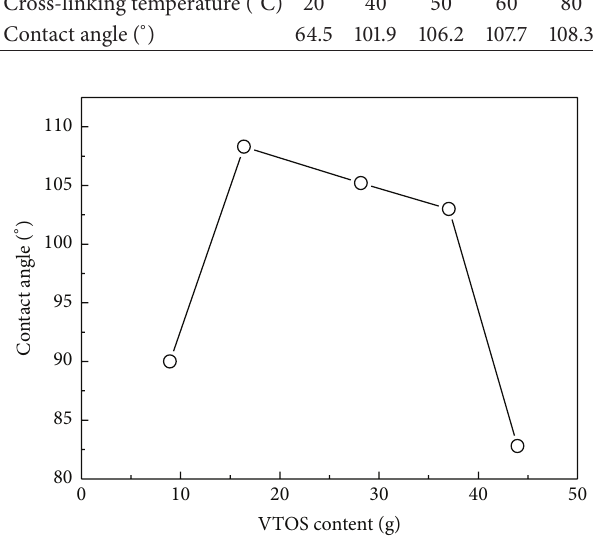
Figure 3: The effect of content of VTOS on contact angle of PDMS- VTOS membranes (the cross-linking temperature: 80 ∘ C).